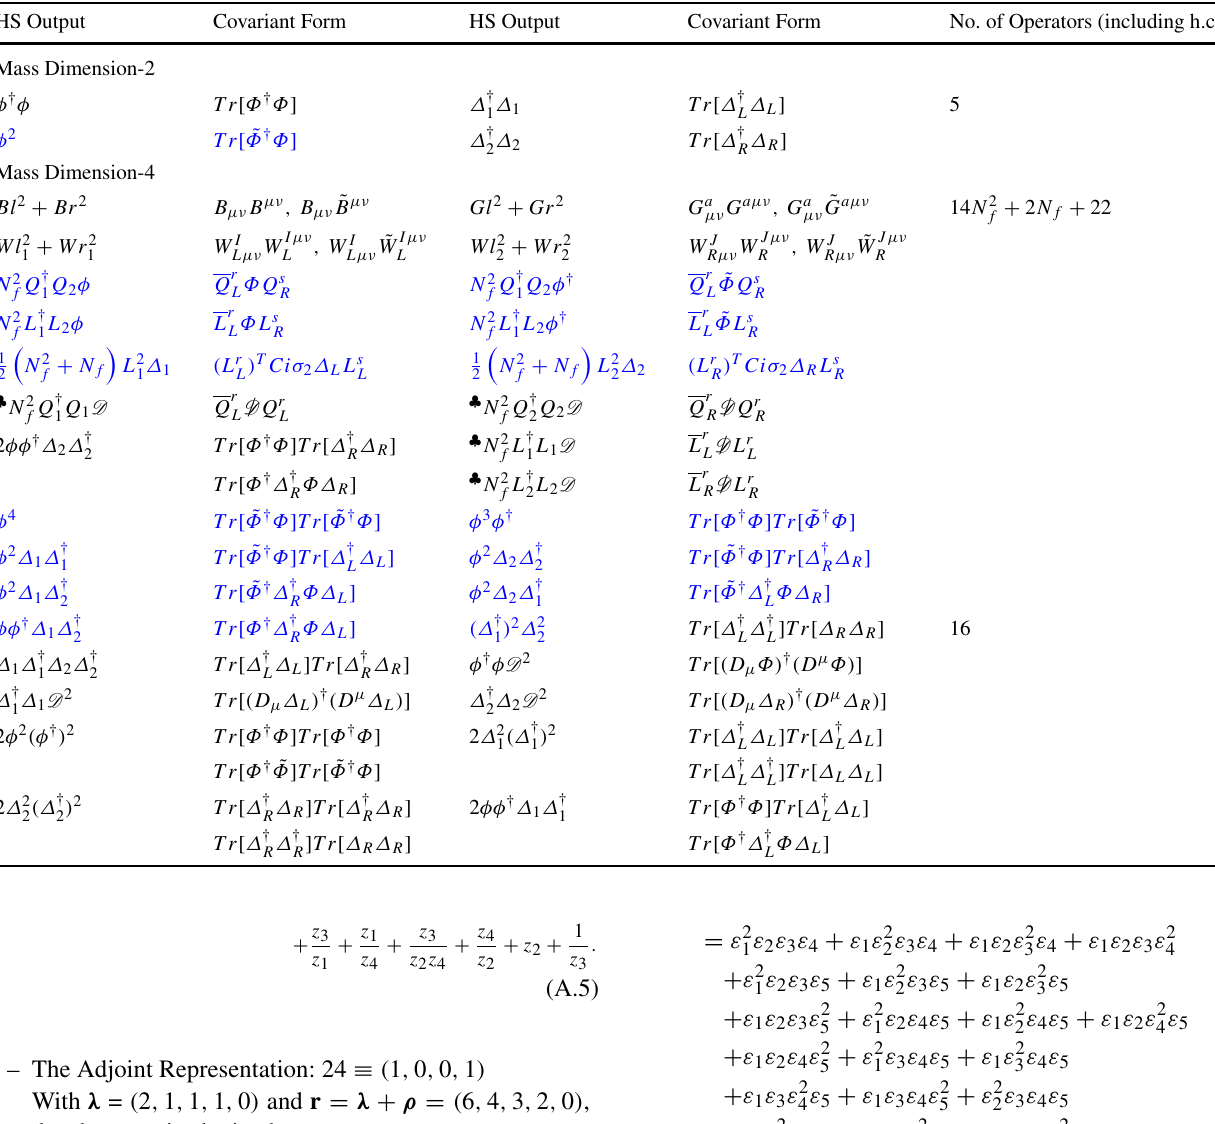
kinetic terms appear with a factor of N 2 but in the physical Lagrangian f there is a flavour symmetry which forces the kinetic terms to be diago- nal and the factor of N 2 is reduced to N f . For the gauge kinetic terms f the translation from the form ( Fl , Fr ) to ( F μν , ˜ F μν ) is accomplished using Eq. (108)